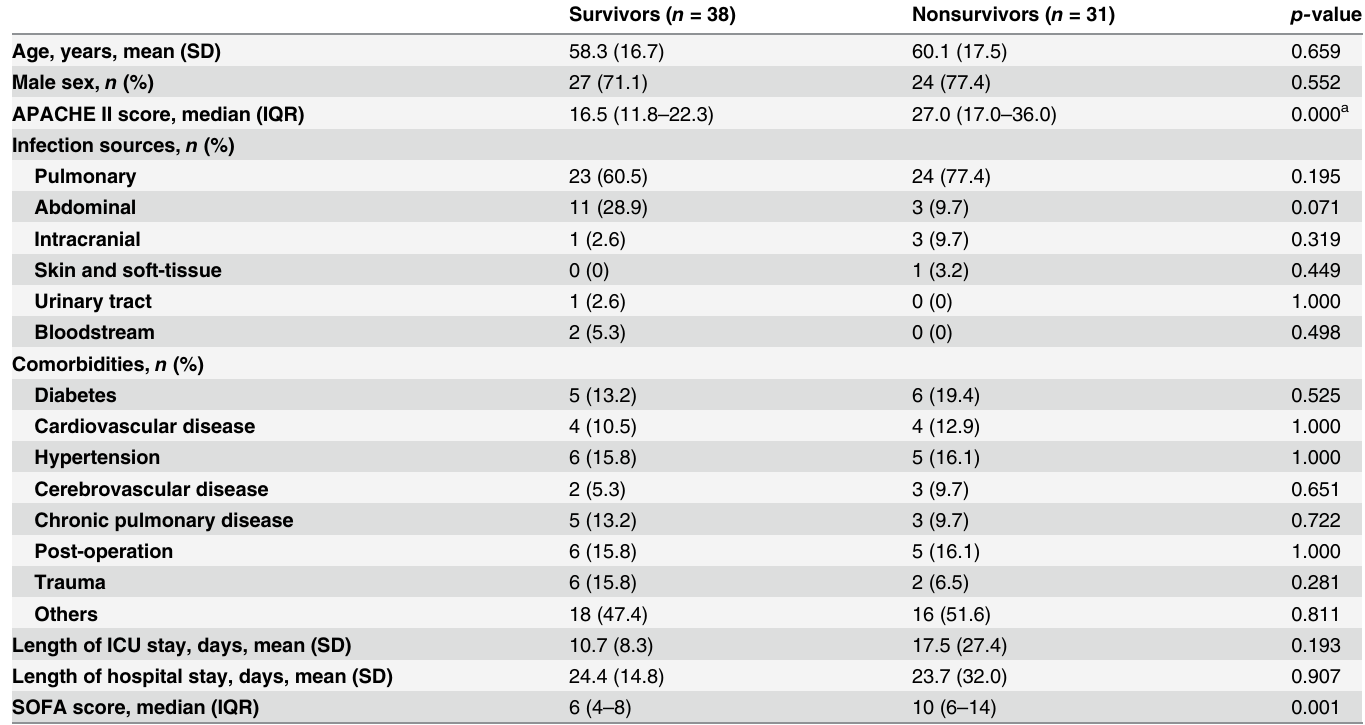
Table 1. Baseline demographics, clinical characteristics, and comorbidities of 69 patients with